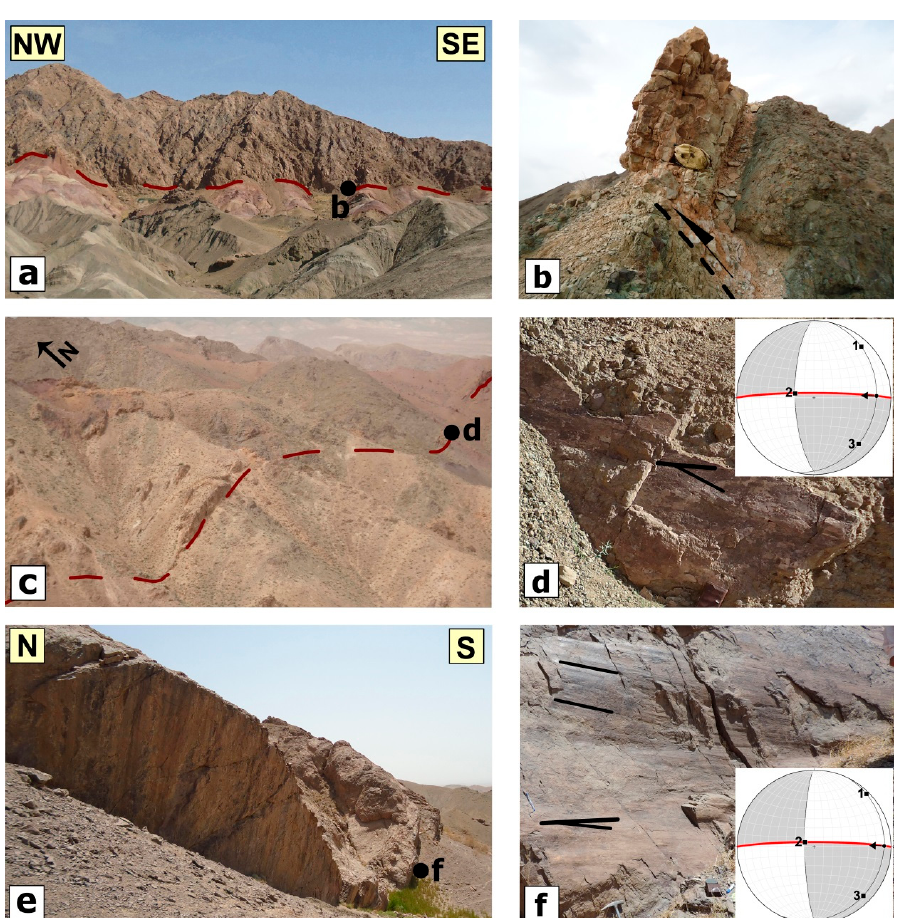
Figure 12. Field images of the western, middle, and eastern parts of the floor fault of the duplex in the Shekarab shear zone. ( a , b ) Trace of the western part of the floor fault between the Eocene and Neogene rock units with attitude of N60 ◦ W, 55 ◦ NW. ( c , d ) The middle part of the floor fault (N90 ◦ E, 85 ◦ N; 088 ◦ /20 ◦ ). ( e ) The floor fault scarp and ( f ) fault plane (N90 ◦ E, 85 ◦ N; 090 ◦ /10 ◦ ) in the eastern part of the duplex. The beach ball diagrams show the left-lateral with reverse motion of the faults.